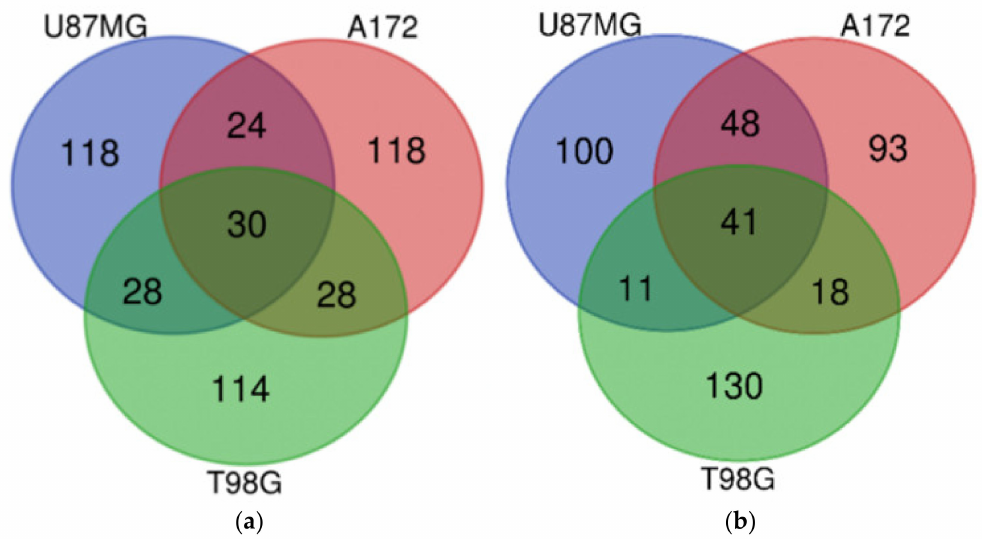
Figure 5. Venn diagrams showing the 200 most significantly modulated genes in Regorafenib-treated U87MG, A172, and T98G cells; ( a ) elevated genes; ( b ) downregulated